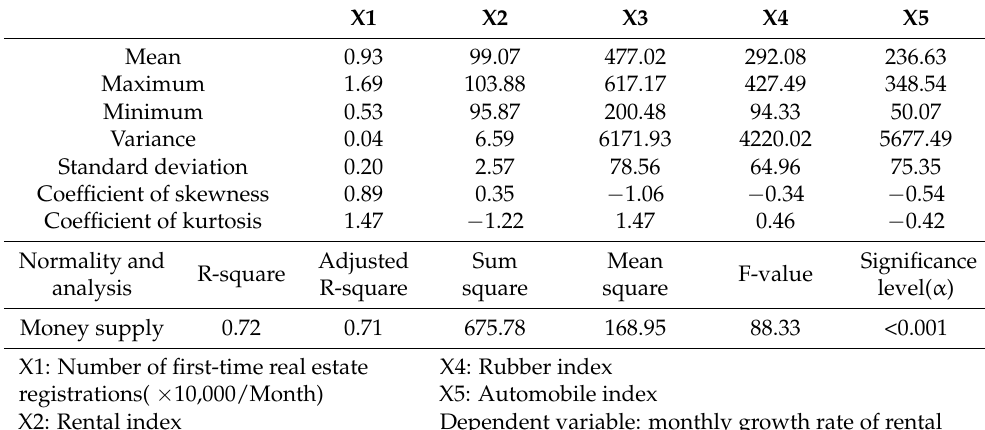
Table 3. Descriptive statistics of indexes related to the rental group from January 2009 to Decem- ber